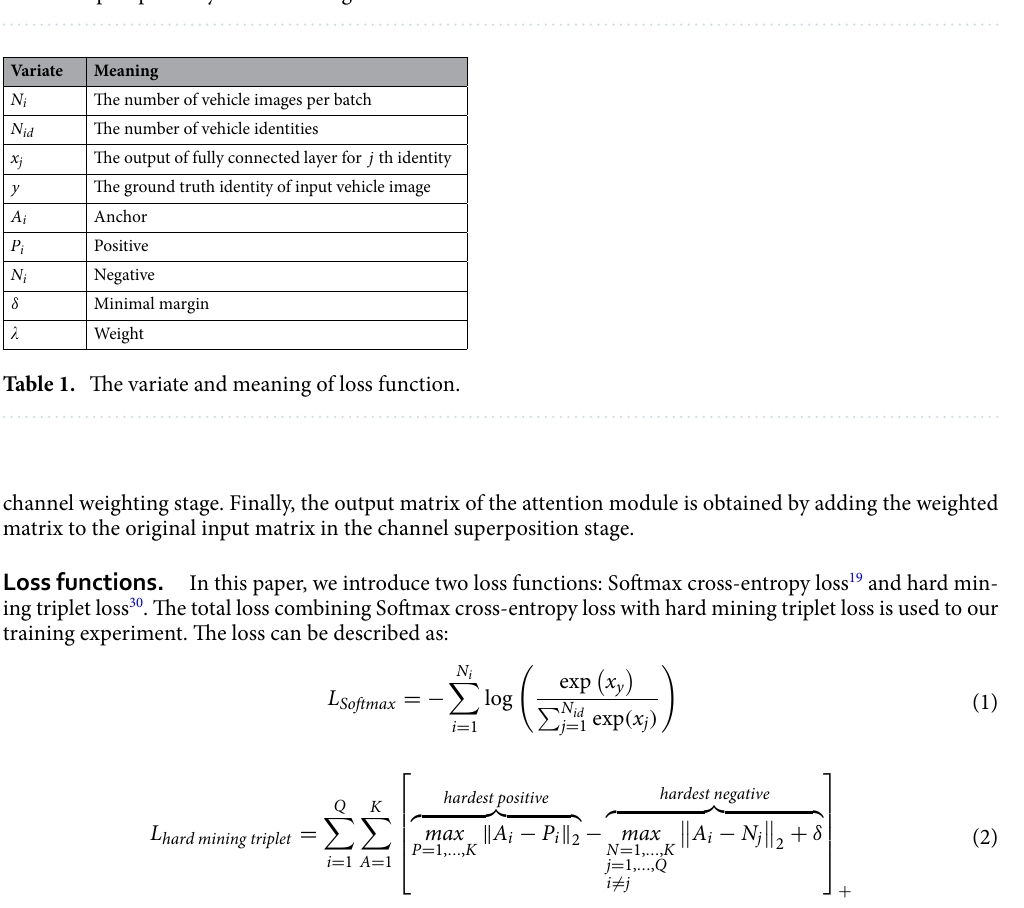
Figure 5. Channel Attention Module (CAM) 29 . H , W , C represent the height, width, and channel number of the feature map respectively. r is the scaling factor.